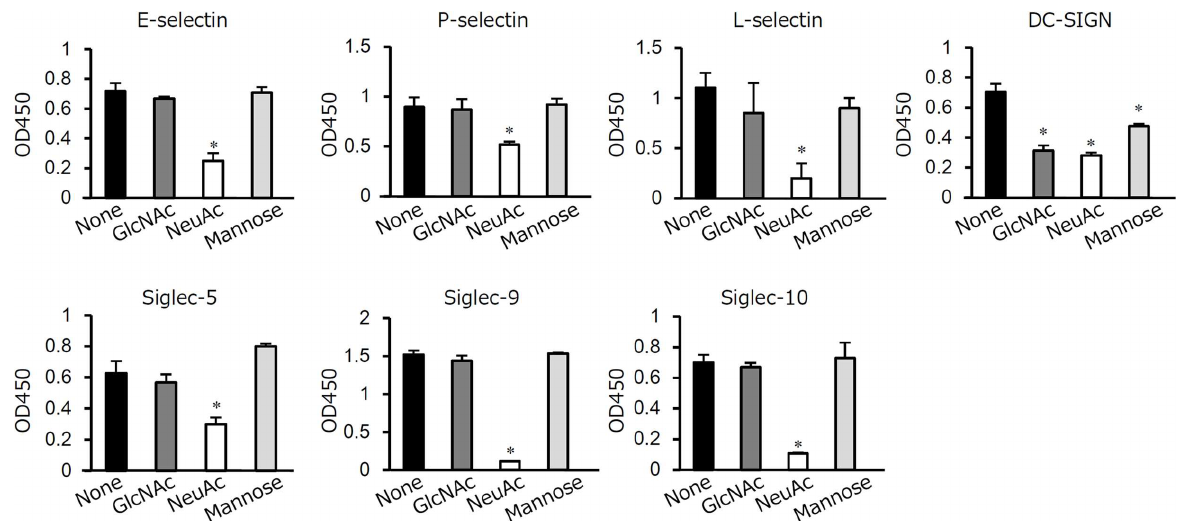
Fig 6. Sugar chains of OmpA-like protein contribute to lectin binding. The wells of 96-well microtiter plates were coated with 5 μ g/ml OmpA-like protein for 18–24 h. After blocking, 200 mM GlcNAc, 200 mM NeuAc, or 10 mM mannose was added to the wells for 2 h before addition of 10 μ g/ml Fc-conjugated recombinant proteins for 3 h. Bindingwas determined by an Fc-specific ELISA. The results are expressed as the mean ± SD (n = 3). * , P <